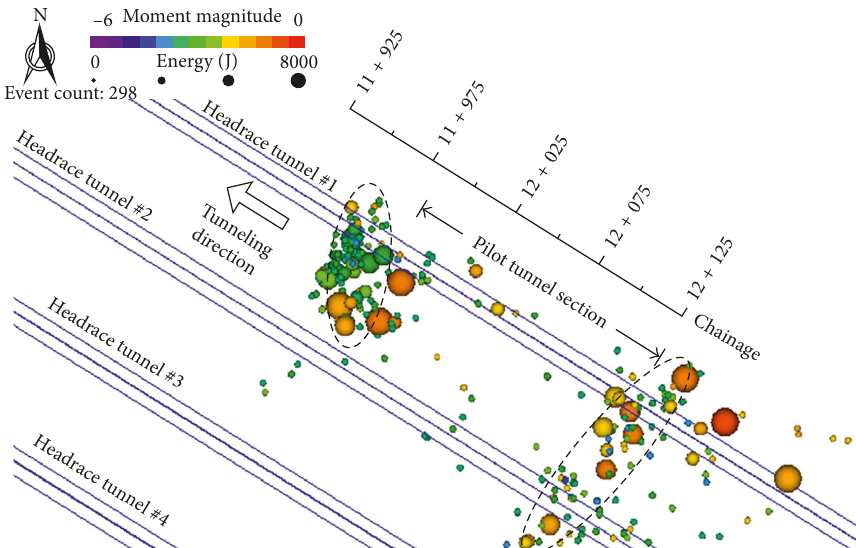
Figure 12: MS events recorded during TBM tunneling from 6 May to 17 June.